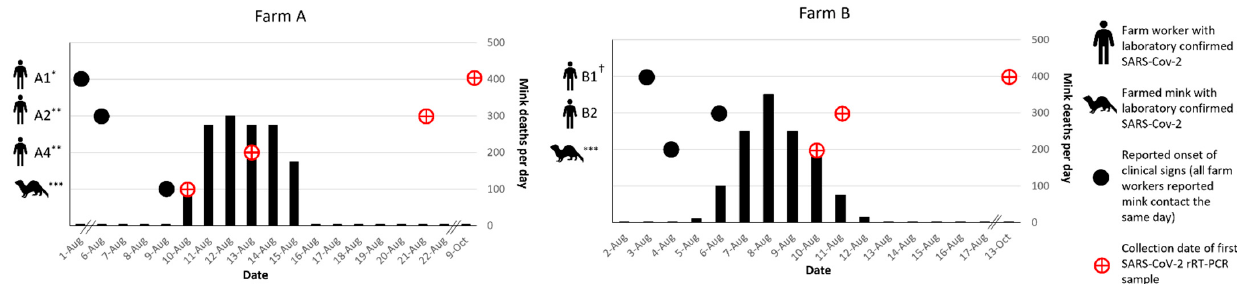
Figure 1. Timeline of symptom onset and SARS-CoV-2 laboratory confirmation in farm workers and in mink relative to onset of increased mortality in mink on Farms A and B. * A1 left work early on 1 August with symptoms but was not tested for SARS-CoV-2 until 9 October (tested positive). ** A2 and A4 both had symptomatic household contacts that tested SARS-CoV-2-positive on 10 and 13 August, respectively. A2 would remain asymptomatic, but ultimately tested positive on 21